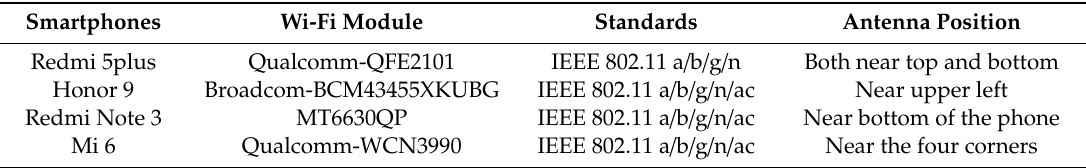
Figure 6. Photos of the experimental scene: ( a , b ) experimental scene photos from different angles and ( c ) data status collection. Table 1. Wi-Fi module conditions of heterogeneous smartphones.